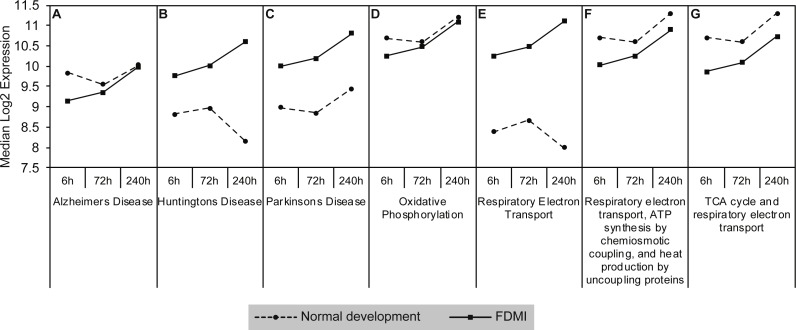
Median expression of pathways involved in mitochondrial metabolism.Graphs of the seven mitochondrial metabolism pathways with significant expression shifts across 240 h of occluder wear relative to unoccluded controls (A) Alzheimer’s disease, (B) Huntington’s disease, (C) Parkinson’s disease, (D) Oxidative phosphorylation, (E) Respiratory electron transport, (F) Respiratory electron transport/ATP synthesis by chemiosmotic coupling and heat production by uncoupling proteins, (G) TCA cycle and respiratory electron transport.